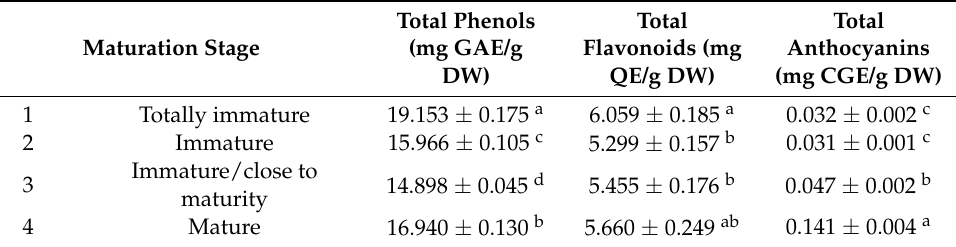
Table 3. Total phenolic, flavonoid, and anthocyanin contents of methanolic extracts of Vaccinium stenophyllum Steud. fruits during